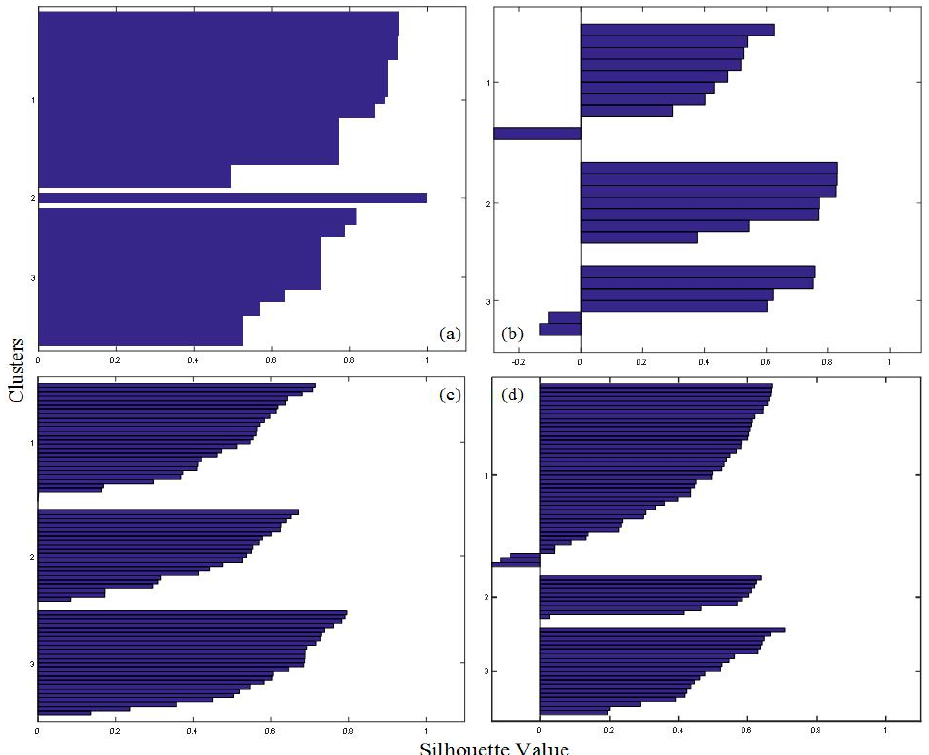
Figure 6. K-means cluster analysis results of Jungnangcheon stream data obtained during the three summer months and first fall month from 2014 to 2016. ( a ) Obtained data clusters from the summer and fall months for three consecutive years; ( b ) temperature clusters; ( c ) DO clusters; and ( d ) pH clusters.